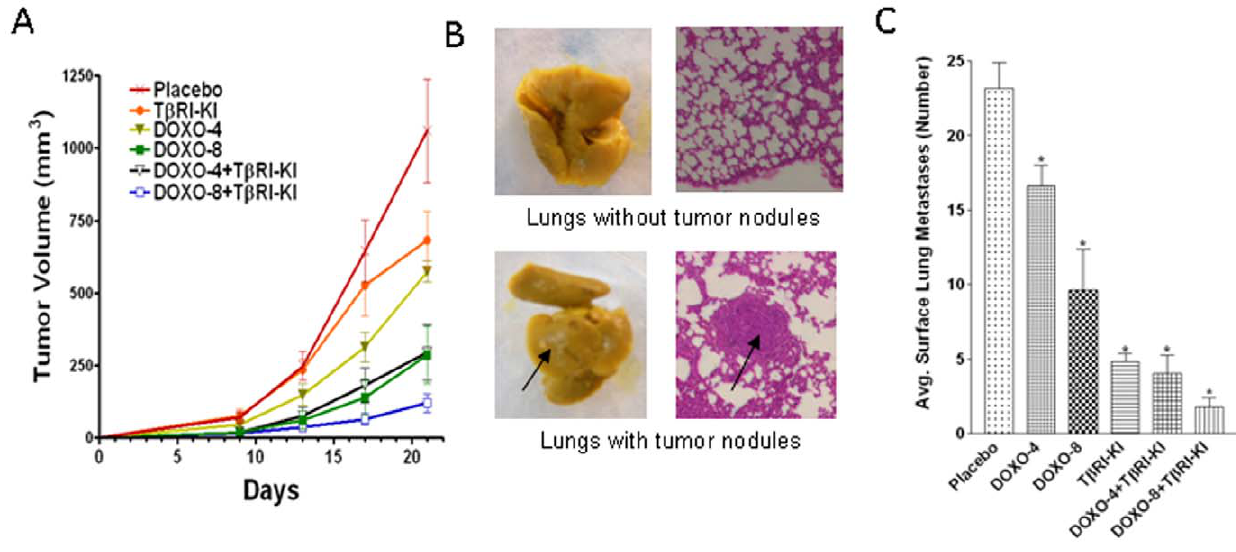
Figure 6. TGF b inhibitor enhances the efficacy of doxorubicin treatment to reduce tumor growth and spontaneous lung metastasis of murine breast cancer cells. A. Murine breast cancer 4T1 cells (0.1 6 10 6 ) were inoculated at the both inguinal mammary fat pad of syngeneic Balb/c mice and divided into six groups. Animals were treated with PBS (Placebo), T b RI-KI at 1 mg/kg every alternative day, doxorubicin (DOXO) at 4 mg/kg (DOXO-4) or 8 mg/kg (DOXO-8) once per 7 days, or the combination of T b RI-KI and DOXO-4 or DOXO-8 through i.v. injection starting at the day of tumor cell inoculation. Tumor sizes were measured twice weekly with a caliper, and the tumor volumes were calculated with the equation V=(L 6 W 2 ) 6 0.5, where L is length and W is width of a tumor. Experiment was terminated after 3 wks of treatment and the final tumor volume (sum of two tumors per mouse) was used for calculating mean tumor volume 6 SEM from 6 mice in Placebo and 5 mice in the rest of the groups. B and C. After the termination of the experiment, lungs were excised and fixed in Bouin’s solution (Sigma) to count surface lung metastasis, followed by paraffin embedding for histological H & E staining. Representative picture of lungs without and with metastatic nodules are shown with corresponding histological identification of the nodules by H & E staining ( B ). The visible surface lung nodules were counted. ‘‘*’’ denotes a significant difference (P , 0.005) from the corresponding control with a Student t test ( C ).